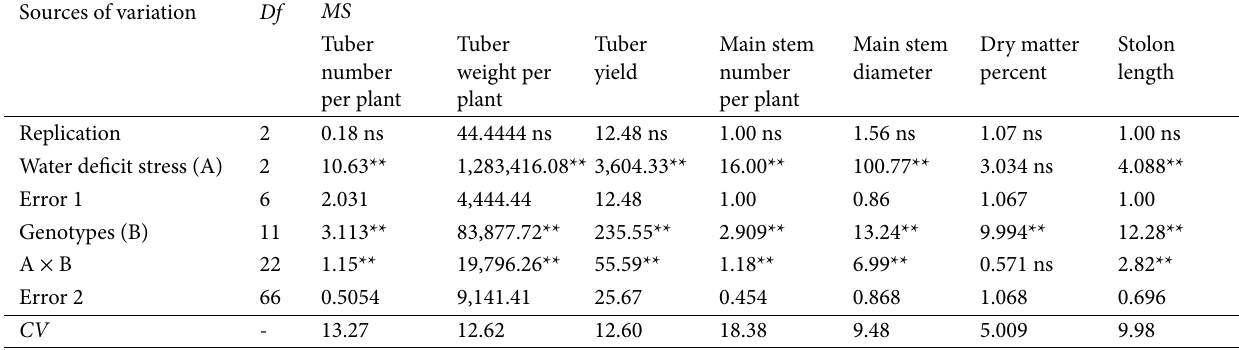
Table 2 Results from the variance analysis of the studied traits in the potato genotypes grown under water deficit stress. Sources of variation